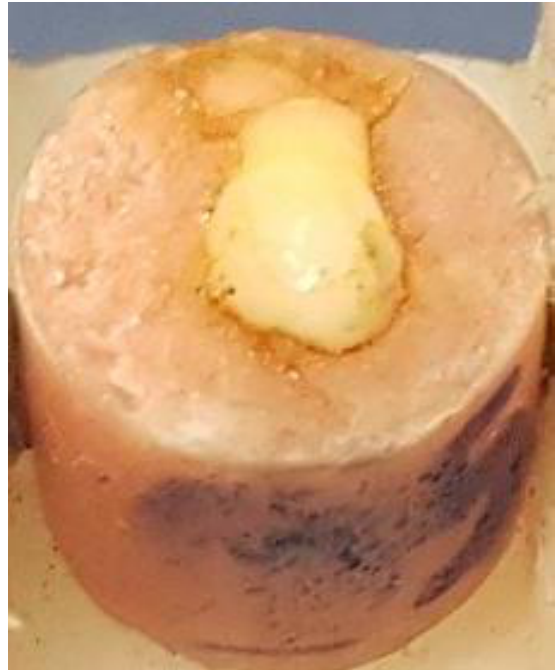
Figure 3. Image of assembly of the natural teeth within the self-cured acrylic resin